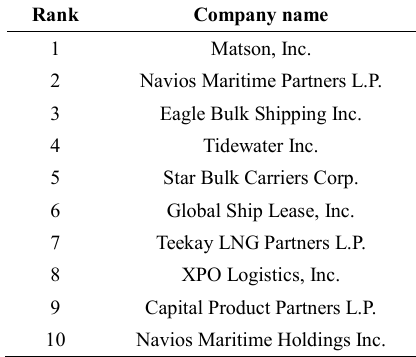
Table 2. The main information transmitter equities, before